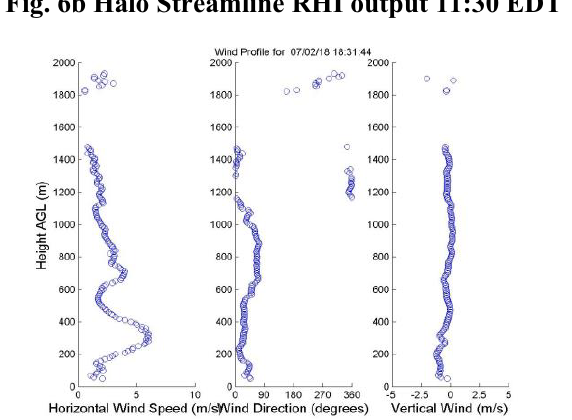
Fig. 7a Halo Pro profiles at 13:30 EDT